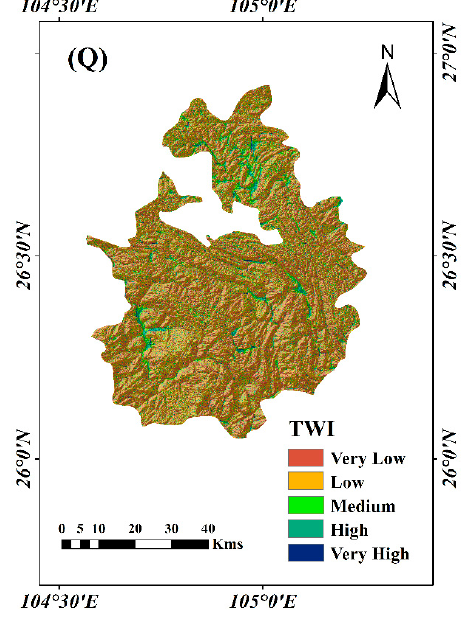
Figure 3. Maps of the spatial distribution of influencing factors. ( A ) Lithology, ( B ) geological age, ( C ) distance to faults, ( D ) elevation, ( E ) slope, ( F ) aspect, ( G ) plan curvature, ( H ) profile curvature, ( I ) land cover, ( J ) NDVI, ( K ) distance to roads, ( L ) distance to rivers, ( M ) annual average precipitation, ( N ) SPI ( O ) STI, ( P ) TRI, ( Q ) TWI.